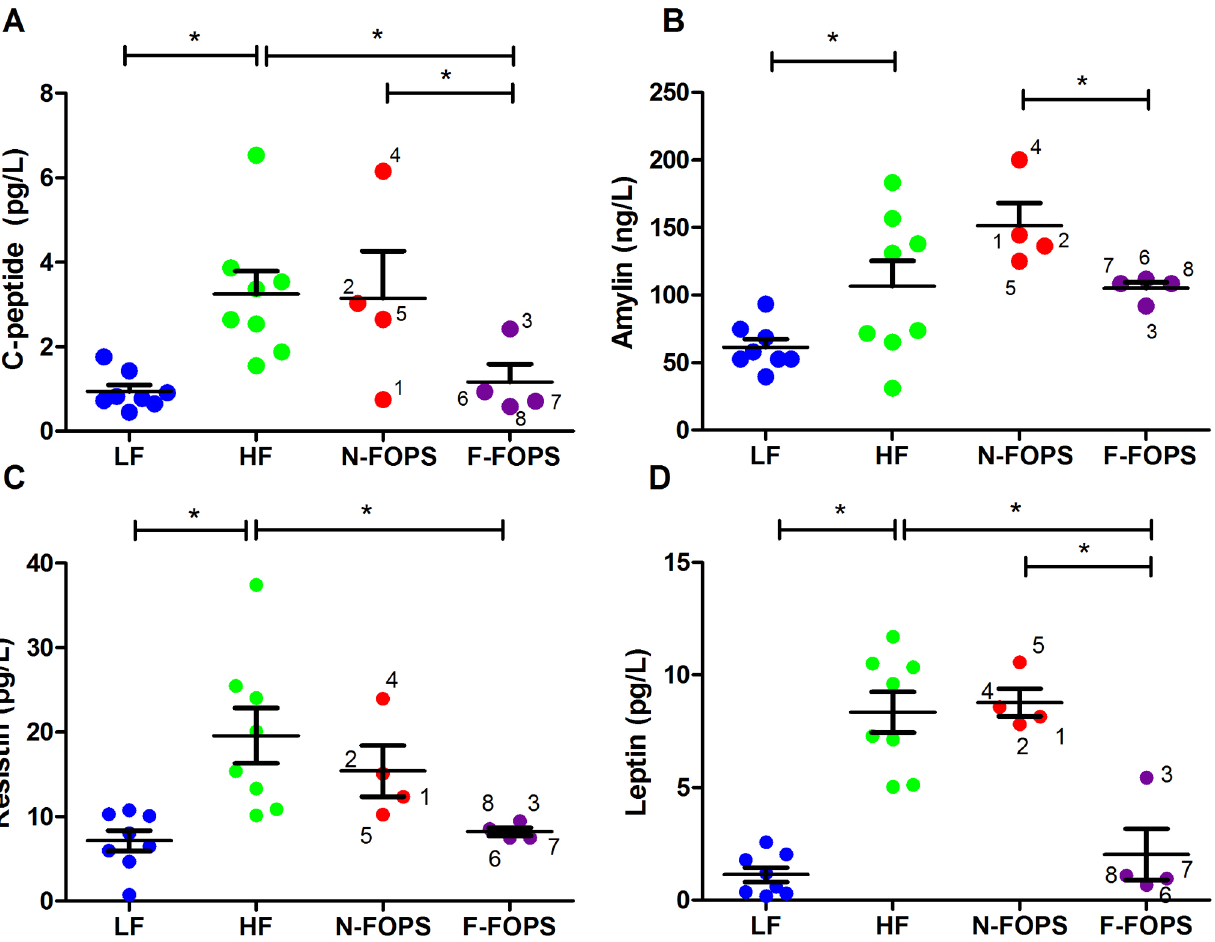
Fig 5. Plasma C-peptide and selected hormone concentrations in mice after 8 weeks of feeding. C-peptide (A), amylin (B), resistin (C), and leptin (D); data are presented as mean ± SEM; n = 8 mice/group for HF and LF; n = 4 mice/group for N-FOPS and F-FOPS; mouse numbers are shown for FOPS mice to track individual mice across figures; * indicates a significant difference (p < 0.05) between the indicated treatments using Bonferroni ’ s multiple comparison test with the following comparisons: LF vs. HF; HF vs. N-FOPS; HF vs. F-FOPS; N-FOPS vs. F-FOPS.